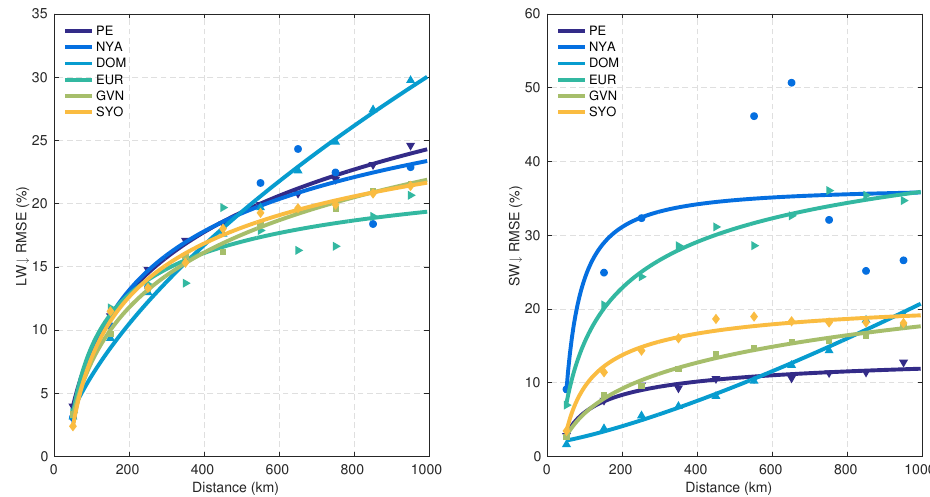
Figure 8. Radiative flux RMSE (%) in function of distance to the POI for six AWS stations, based exclusively on 2B-FLXHR-LIDAR data (2007–2010). The RMSE is calculated based on all satellite tracks that pass within 50km of the POI, where the retrieved radiative fluxes at a certain distance were compared to the retrieved fluxes within 50km of the POI. These RMSE estimates represent the combined uncertainties in the radiative flux retrievals that arise from differences in atmospheric conditions between the satellite footprints and the POI.